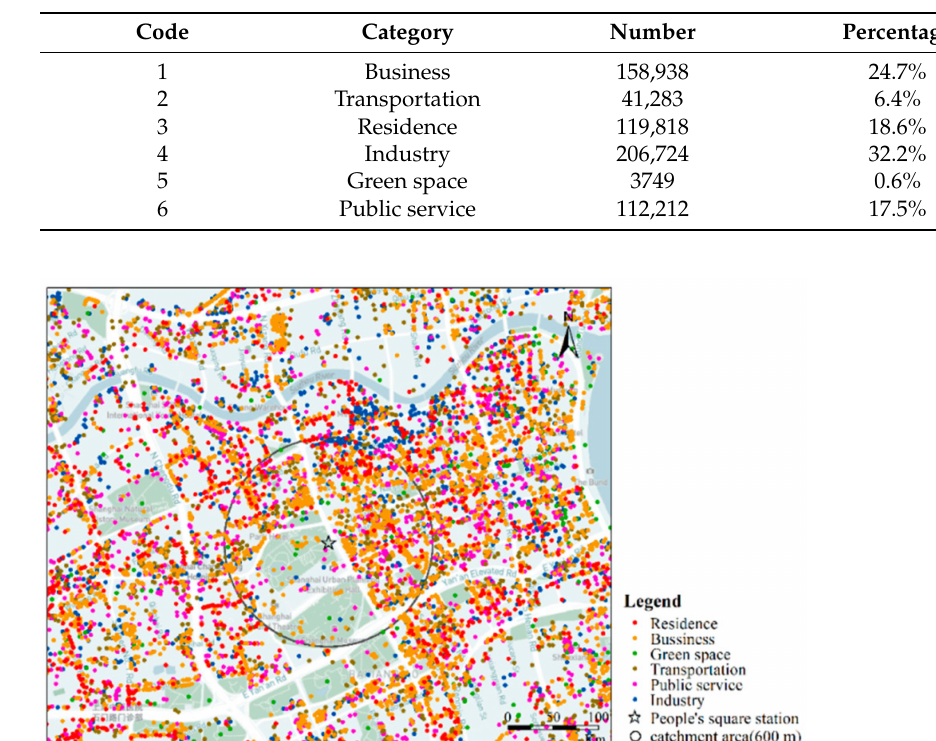
Table A1. The results of reclassification POI.